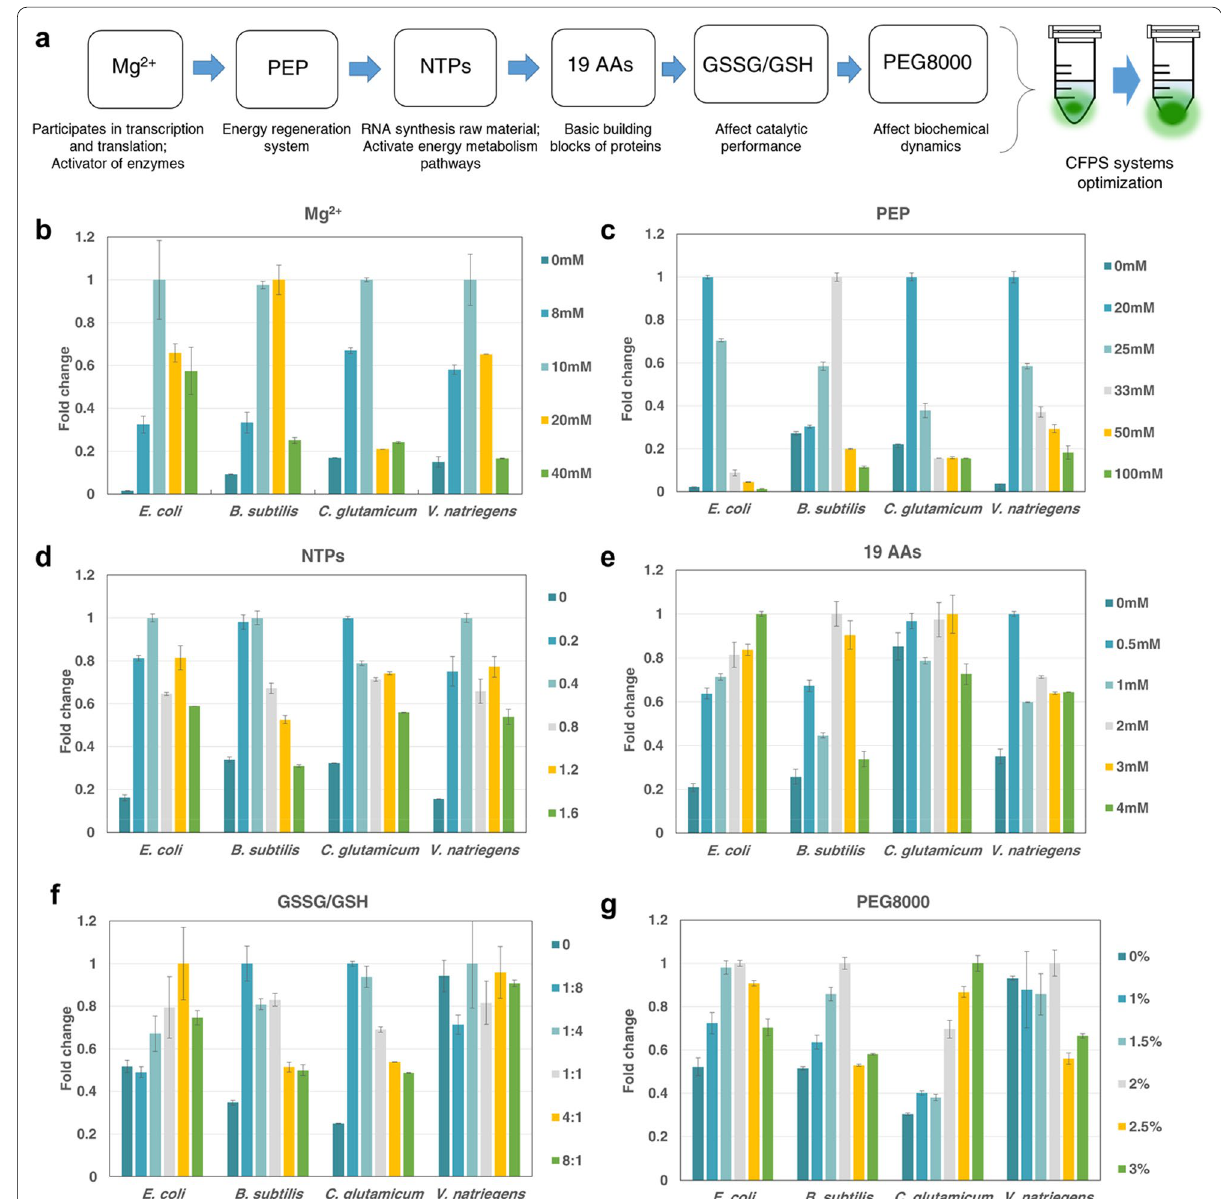
Fig. 5 Effect of system reagent components on E. coli , B. subtilis , C. glutamate and V. natriegens CFPS systems. a Optimization process of reagent components in the system. b Mg 2 + . c PEP. d NTPs. e 19 AAs. f Redox environment. g PEG8000. Normalized treatment of sfGFP protein synthesis levelobtained by the system when using each reagent at a specified concentration. The mean and standard deviations are shown (N number "1" of the normalized treatment represented the optimal fluorescence value of each factor in each CFPS